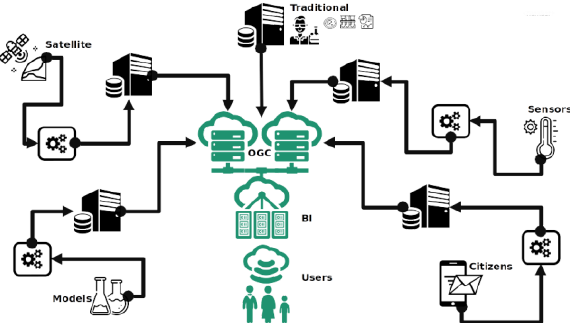
Figure 6. General architecture of the Business Intelligence platform envisioned in the SIMILE